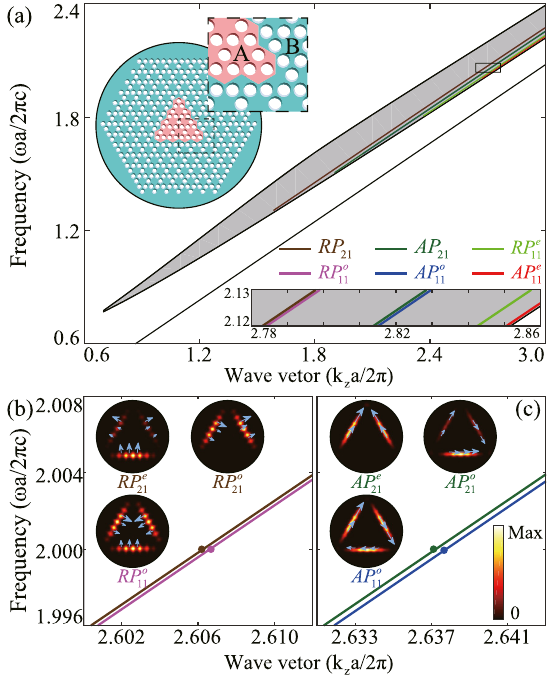
Figure 2: Azimuthally and radially polarized modes in TPCF. (a) Fiber dispersion in topological gap. The top left inset is the structure of the valley topological photonic crystal fiber. The downright inset is the enlarged view of fiber dispersion in solid line box. (b) Dispersions and the electric field distributions of the RP o modes. (c) Dispersions and the electric field distributions of the RP o 21 , AP e , and AP o modes. The blue arrows indicate AP o 11 21 21